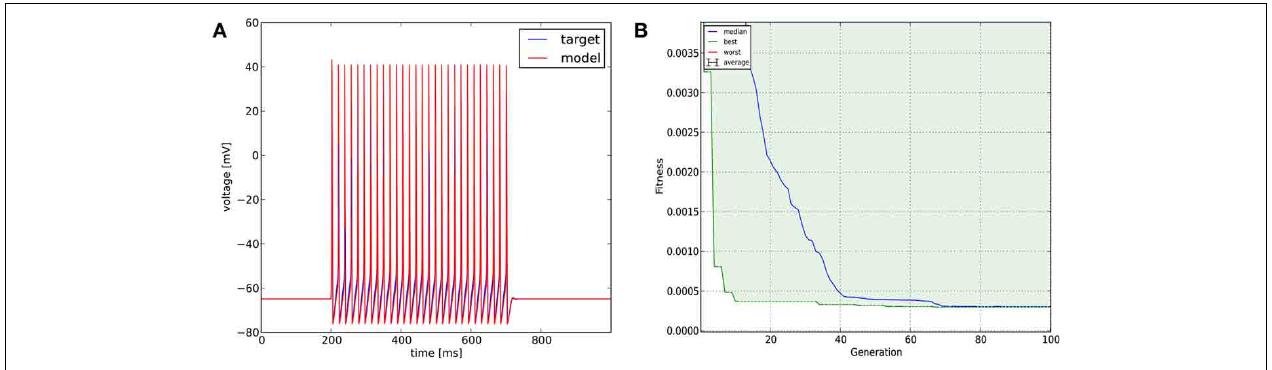
FIGURE 4 | The results of Optimizer on Use case 1 (fitting conductance densities in the Hodgkin-Huxley model). (A) Comparison of the original (surrogate) data (blue) and the best-fitting